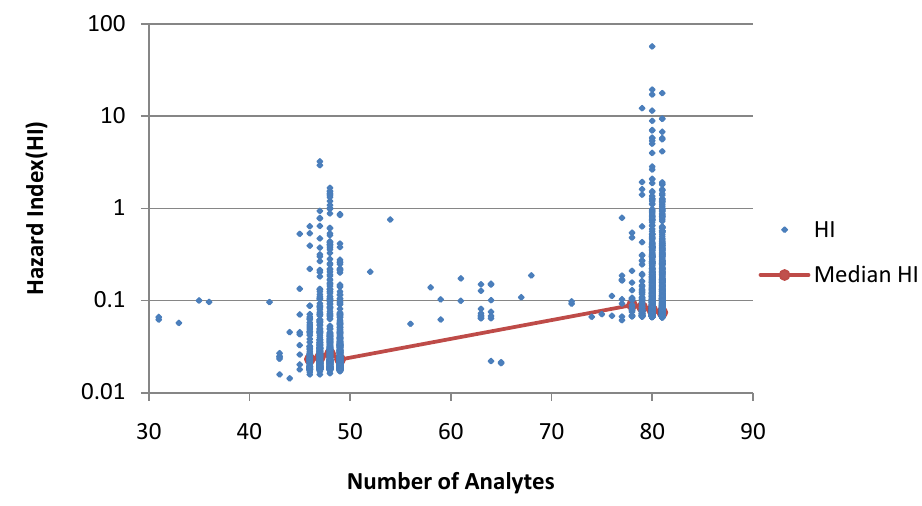
Figure 3. The relationship between HI and n for Case 2. HI and n have a weakly positive correlation, Kendall’s tau-b value of 0.34 (p < 0.0001) based on all samples. Correlation based on medians of grouped samples is not statistically significant (p >